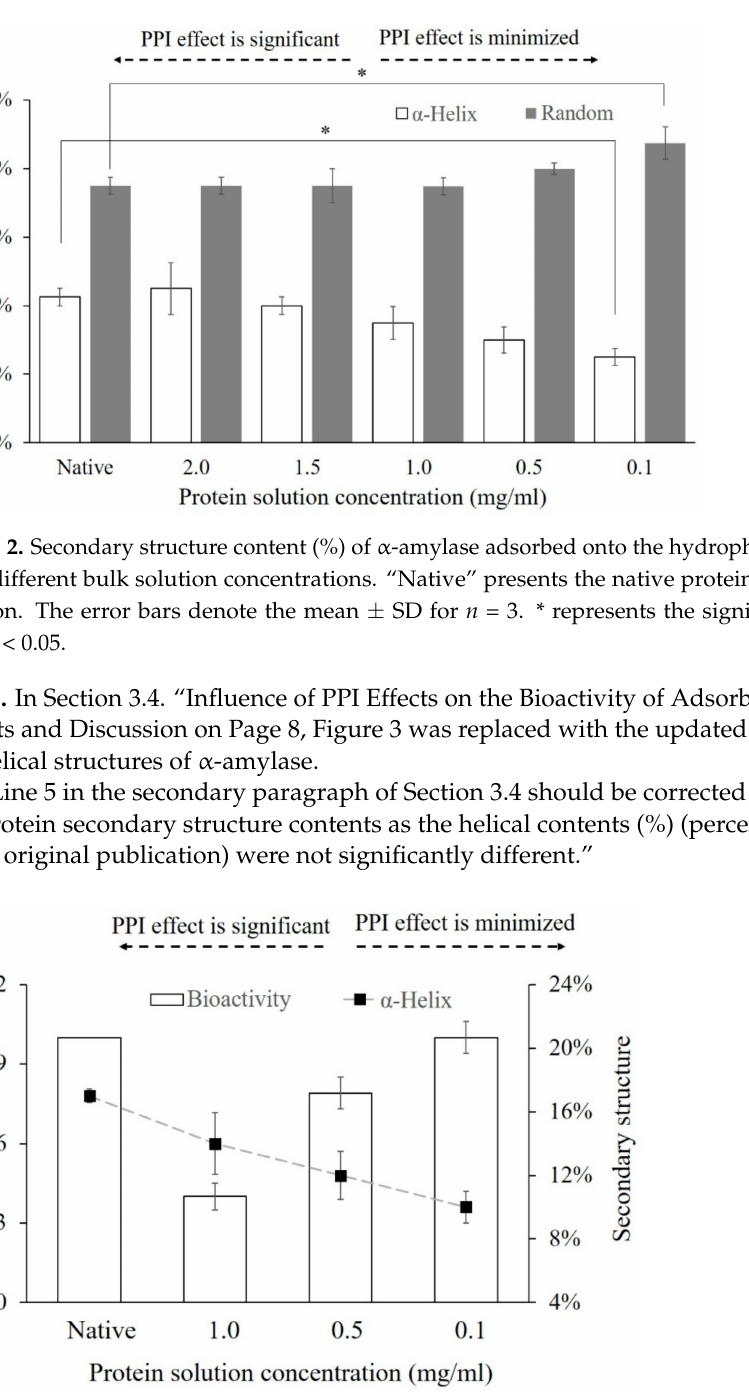
Figure 3. Comparing the relative bioactivity of α -amylase adsorbed on the glass surface at different protein solution concentrations and the secondary structure change ( α -helix (%)) obtained. “Native” presents the native protein structure and relative bioactivity in the solution. The error bars denote the mean ± SD for n =